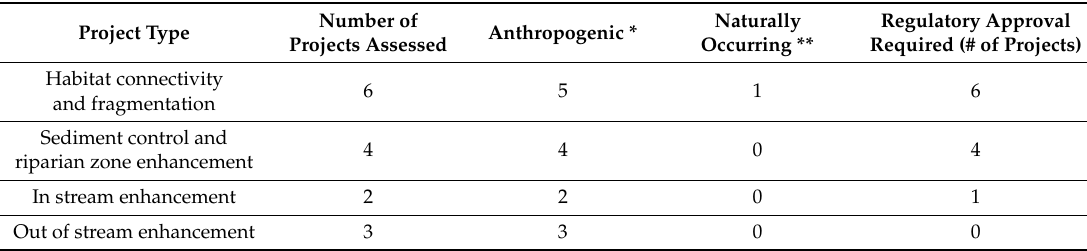
Table 2. Summary of Restoration